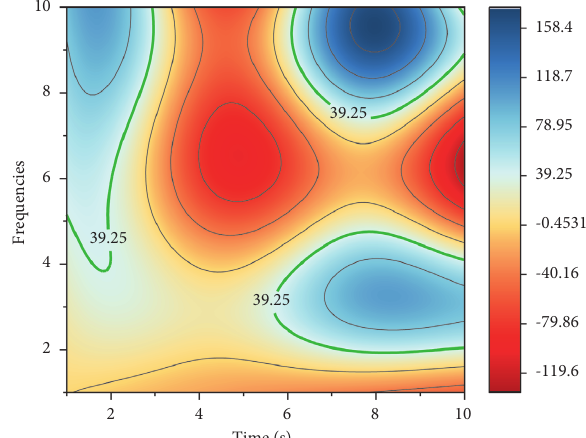
Figure 5: Time-series domain partitioning based on support vector machine class